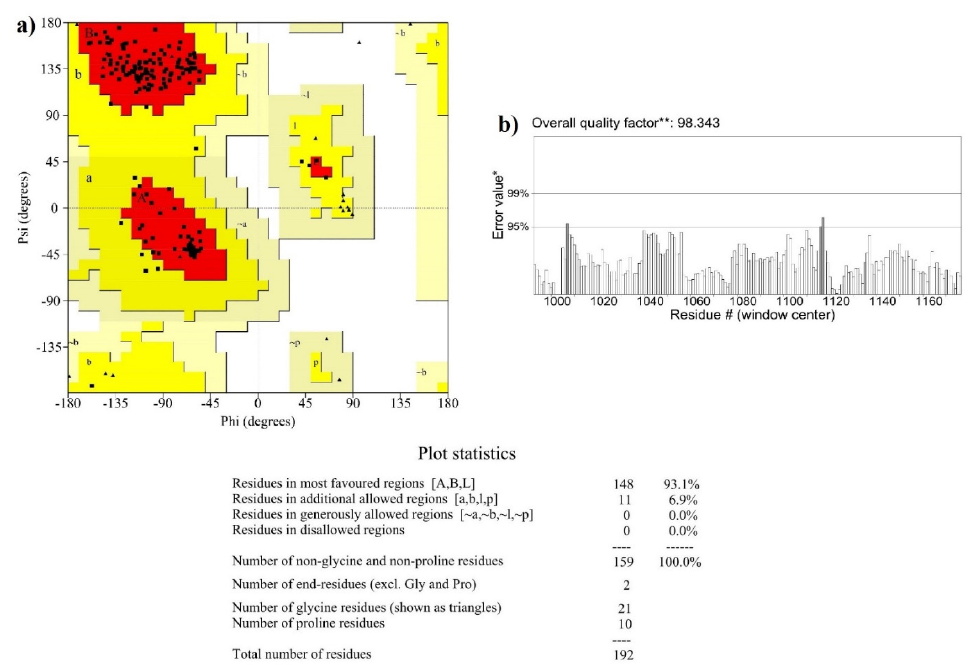
Figure 4. Characteristics of PDB ID: 4WF8 (HCV NS3/4A crystal structure). ( a ) Ramachandran plot by PROCHECK. ( b ) Overall quality prediction by ERRAT. * On the error axis, two lines are drawn to indicate the confidence with which it is possible to reject regions that exceed that error value. ** Expressed as the percentage of the protein for which the calculated error value falls below the 95% rejection